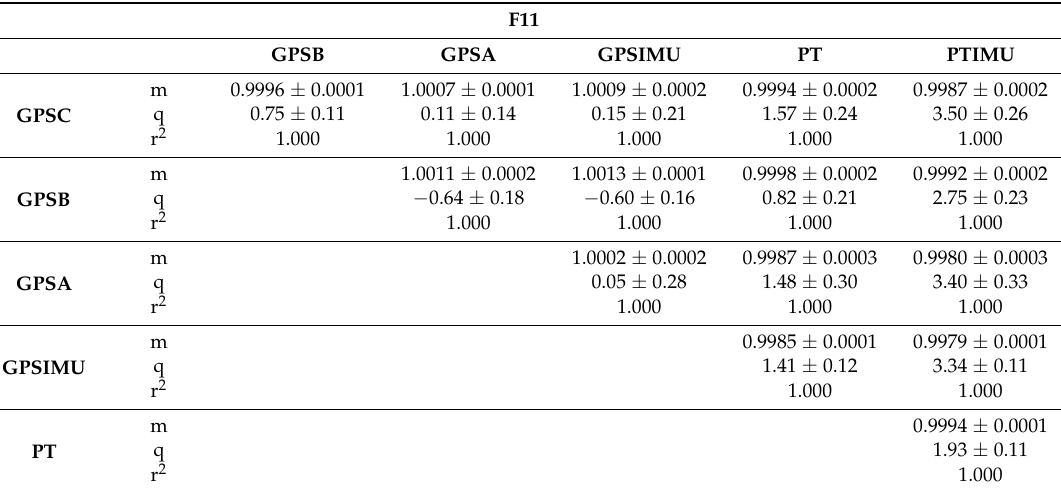
Table A4. Linear regression data of F11 (DATASET2 β